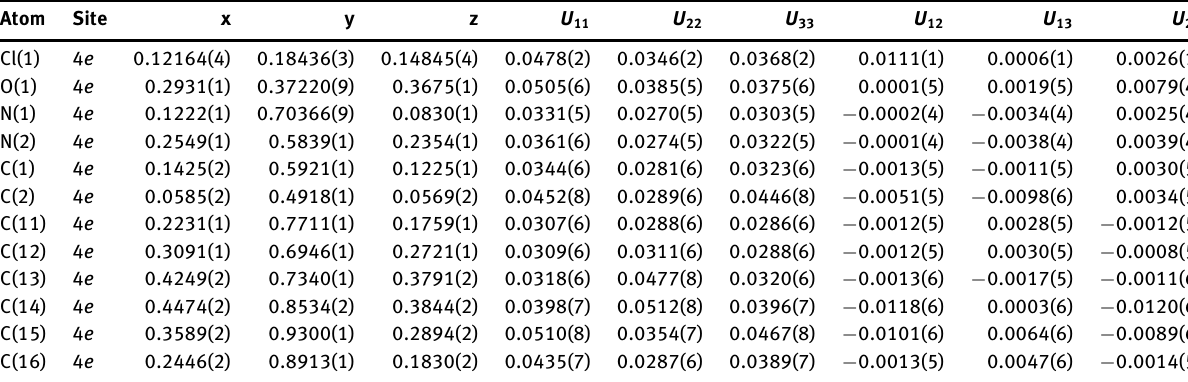
Table 3: Atomic coordinates and displacement parameters (in Å 2